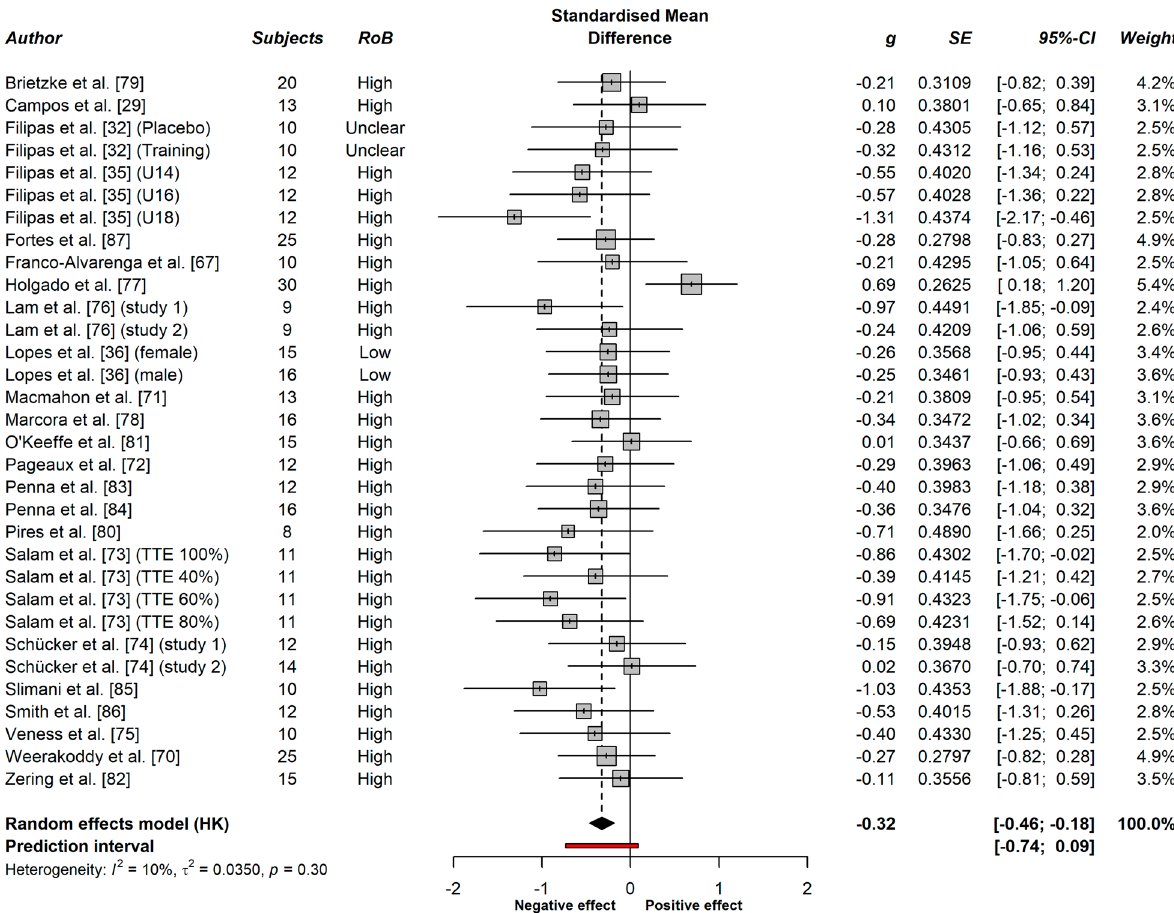
Hedges’ g; RoB Risk of Bias; SE standard error; TTE time to = = = =